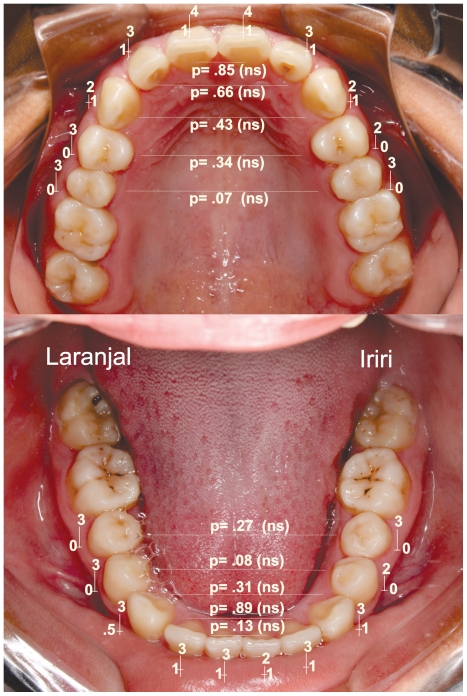
Descriptive statistics for tooth wear in the upper and lower jaw.Median (−), minimum and maximum values for the Arara-Laranjal (left side, n = 58) and Arara-Iriri (right side, n = 23) populations. P values were obtained using a Mann-Whitney test.